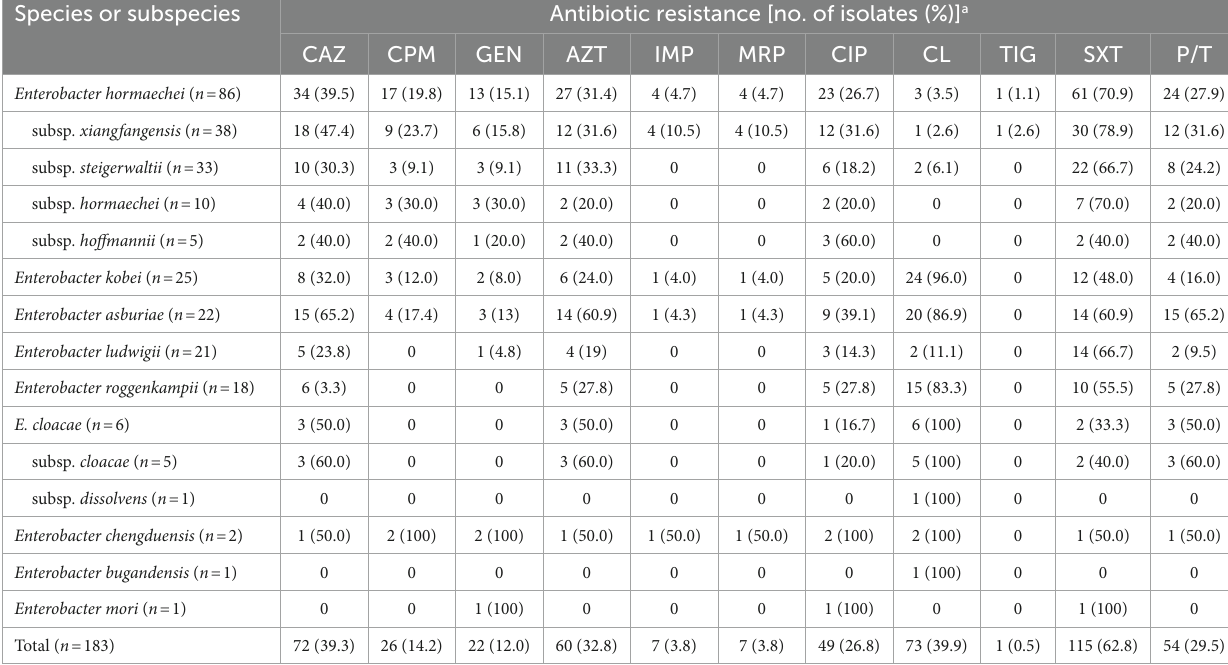
TABLE 2 Antibiotic resistance in each species or subspecies of Enterobacter cloacae complex (ECC). Species or